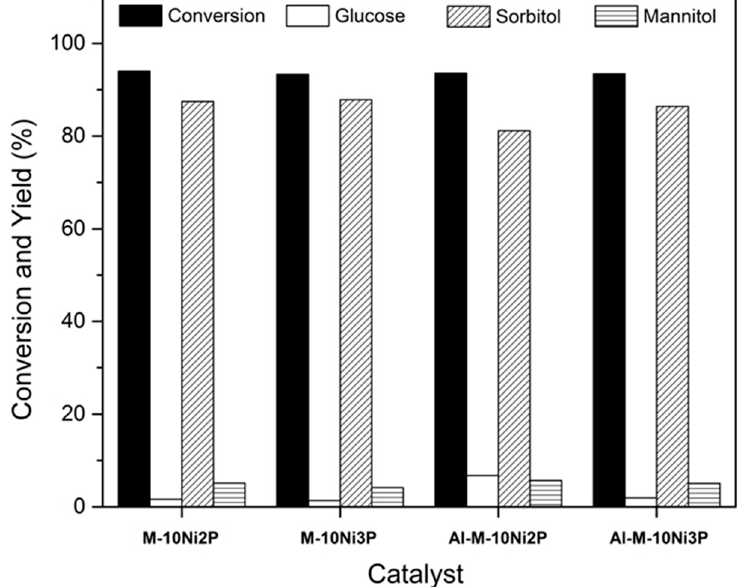
Figure 8. Catalytic performance of M-xNiyP and Al-M-xNiyP catalysts for the hydrolytic hydrogenation of cellobiose at 180 °C, 3 h, 4 MPa of H 2 , 10 mL of 1% cellobiose solution, and 0.08 g of catalyst.